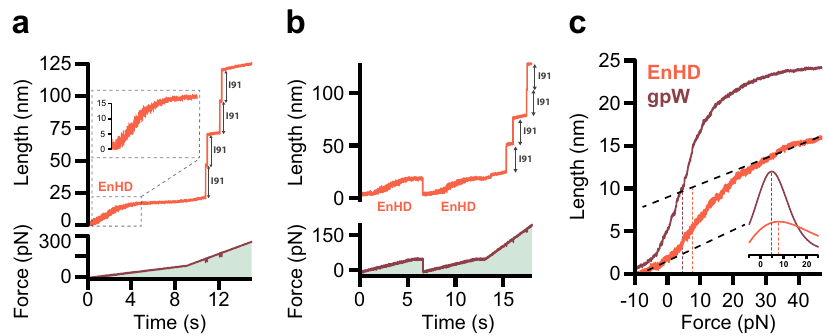
Fig. 3 Single-molecule force – ramp experiments. a Time series for the measured extension (top) and force (bottom) in a force-ramp experiment at 10pNs − 1 loading rate for EnHD. The inset highlights the signal corresponding to EnHD unfolding. b Same as a , but now including two consecutive low loading-rate force ramps separated by a force-quench to zero force. c Average force/length curve from multiple traces for EnHD and protein gpW ( n = 29 independent traces from multiple experiments) at 10pNs − 1 . Vertical dashed lines mark the mid-unfolding force ( F 1/2 ) for EnHD (red) at 7.6pN, and gpW (brown) at 4.6pN. Propagating baselines (black dashed lines) provide an estimated extension of about 7.5nm for EnHD. The inset is the fi rst derivative of the sigmoidal fi t, indicating also mid- unfolding force.